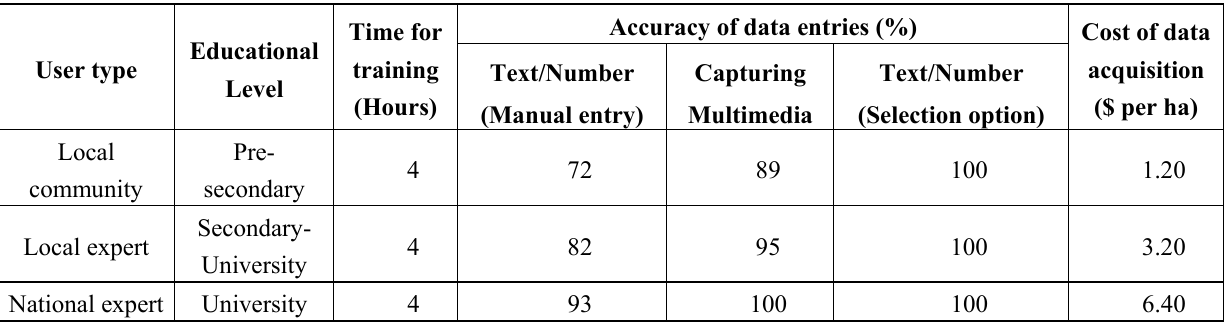
Table 3. Evaluation matrix of data entry types and